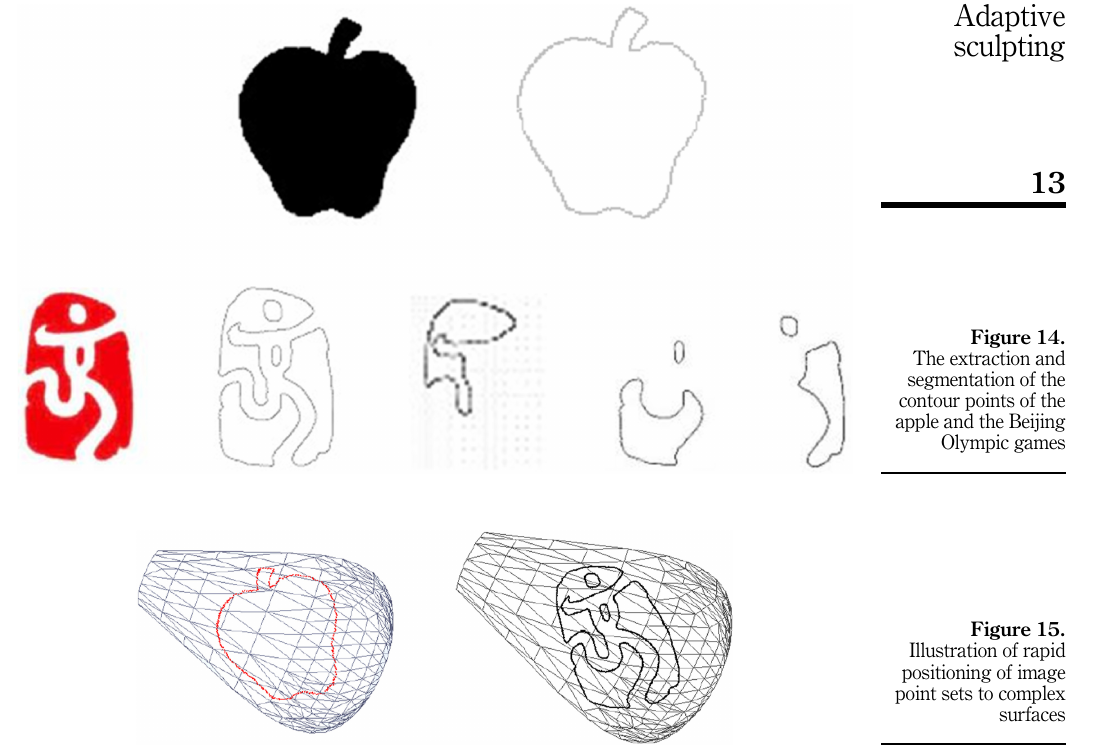
Figure 15. Illustration of rapid positioning of image point sets to complex